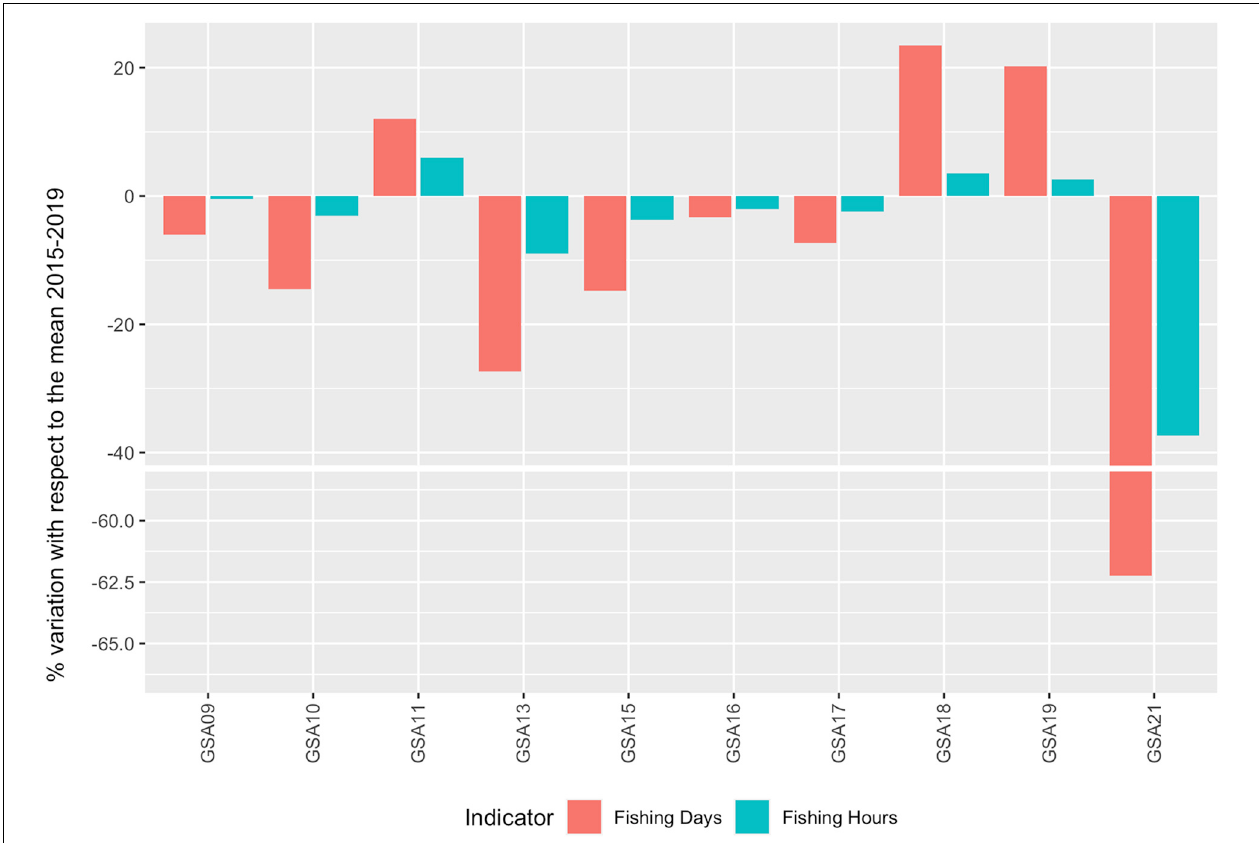
FIGURE 7 | Pattern of changes (difference in percentage between the total yearly value of Fishing Days and Fishing Hours in 2020 and the mean values during the years 2015–2019) for each